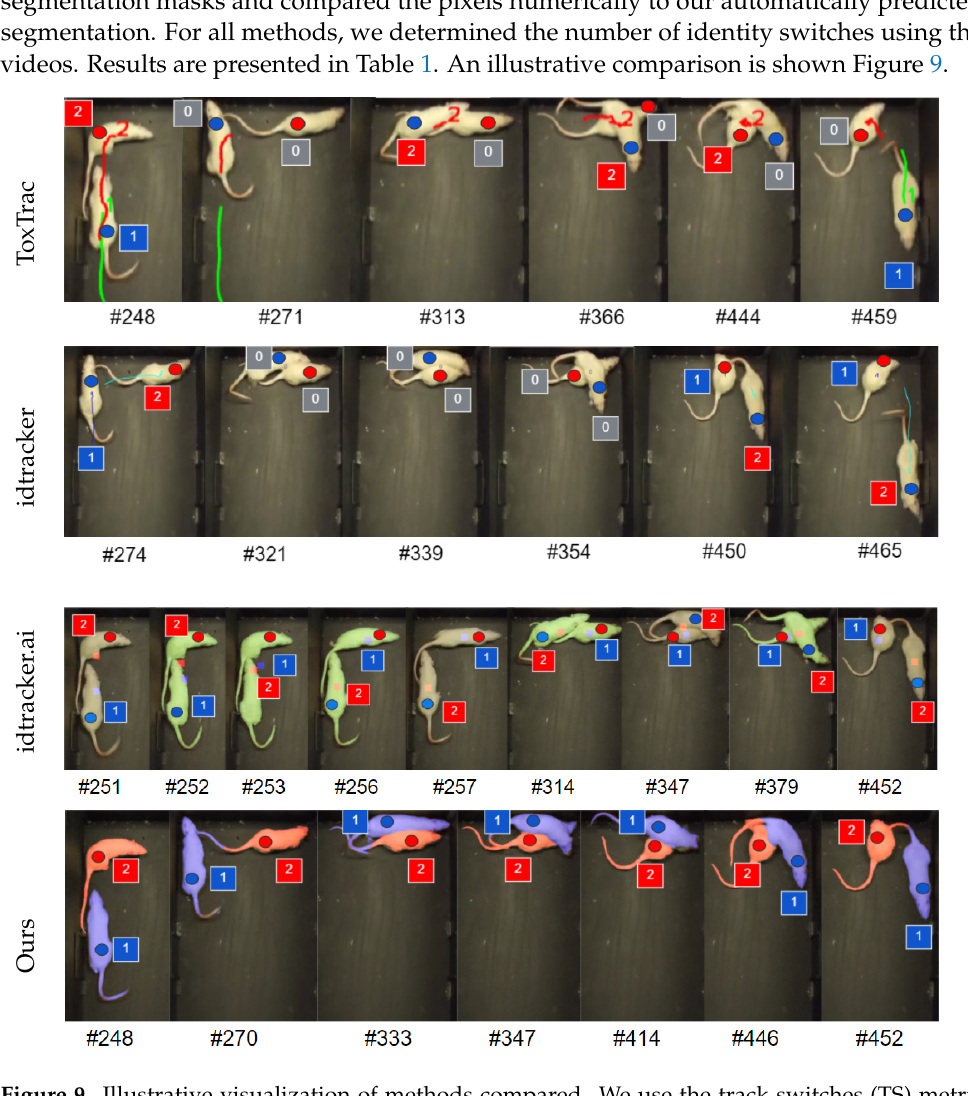
Figure 9. Illustrative visualization of methods compared. We use the track switches (TS) metric from [9], which measures the number of ID switches during tracking. Errors are shown for ToxTrac, idtracker, idtracker.ai in the first three rows. The results of our method (with S EPA R ATS ) for the most challenging frames are given in the last row showing no errors. The small circles denote the ground truth IDs (blue for instance with ID 1 and red for instance with ID 2), the squares denote the predicted ID labels. Gray denotes “lost ID”, missing ID